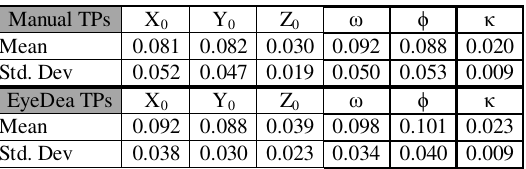
Table 8. Statistics of accuracies of EO parameters in LPS (lengths in meters, angles in degrees)